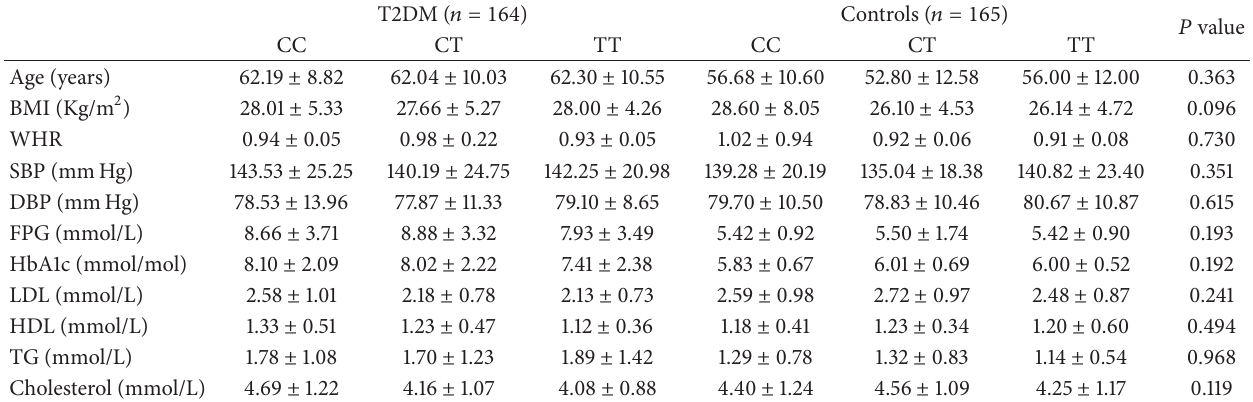
Table 5: Clinical and biochemical characteristics among subjects according to genotypes of R230C.